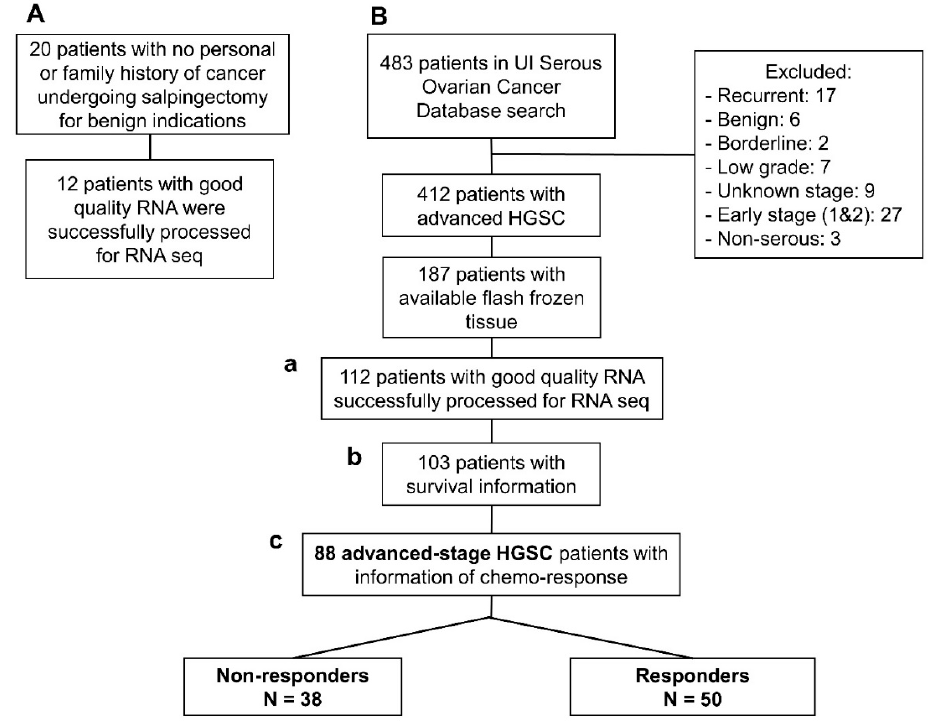
Figure 1. Flow-chart of patients included in this study: ( A ) Normal fallopian tube samples from women undergoing contraceptive procedures. ( B ) Patients with high-grade serous ovarian cancer (HGSC) from the Women’s Health Tissue Repository: ( a ) 112 patients with HGSC and successful RNA-seq that were included in the comparison with lncRNA extracted from normal tubes; ( b ) 103 HGSC patients with successful RNA-seq that had outcome and follow-up data necessary for the survival analysis; and, ( c ) 88 advanced stage, high-grade, HGSC with data about chemotherapy response based on the definition stablished in the Methods section.